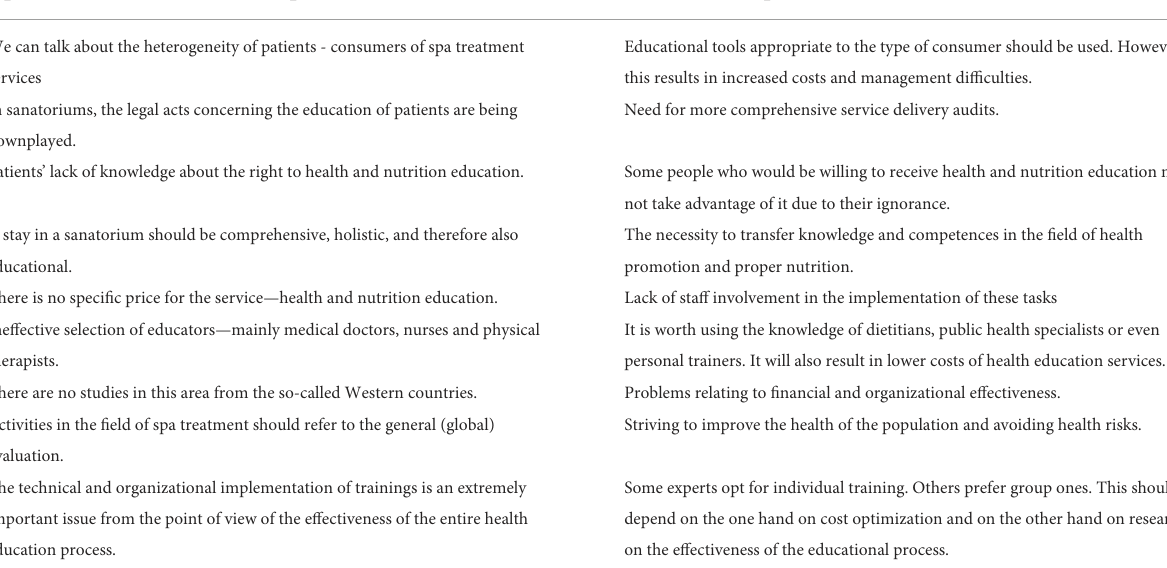
TABLE 3 Opinions and observations of experts in the field of organizational tasks (including management and financial aspects). Opinions and observations of